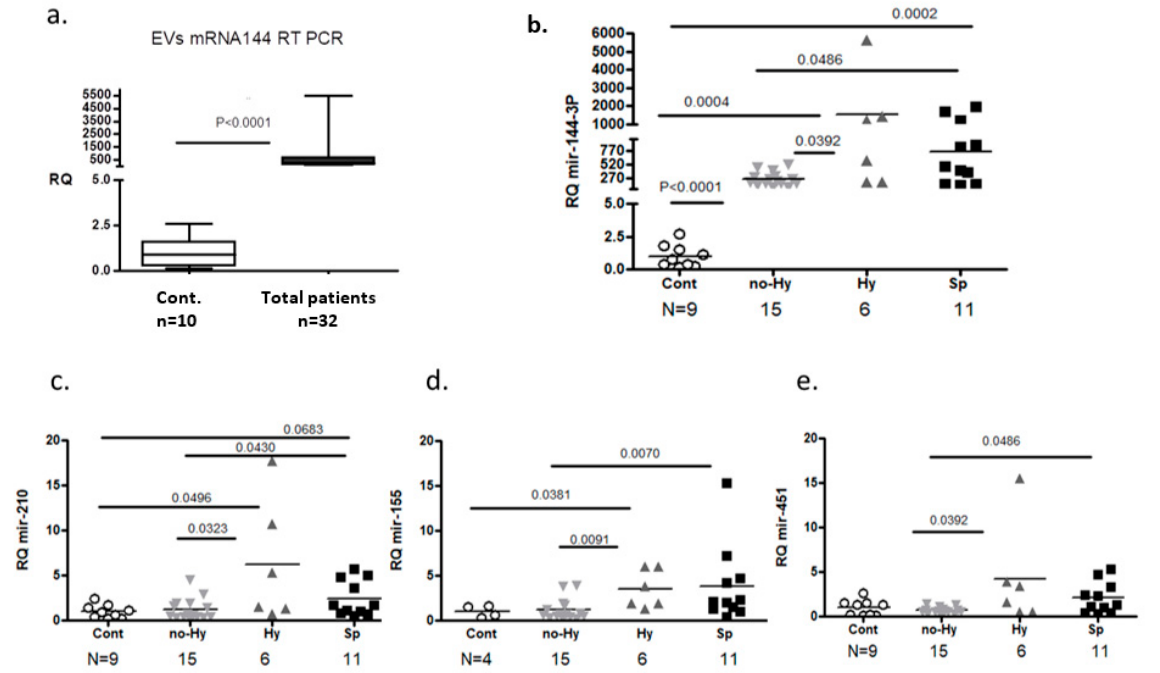
Figure 3. Relative expression levels of extracellular vesicle (EV) miR-144-3p by RT-qPCR. ( a ) Controls (Cont) (N = 10) vs. the total β thalassemia (Total β T) group. ( b – e ) Controls vs. β T subgroups (hypersplenism (Hy), no hypersplenism (no-Hy), splenectomized (Sp)) miR-144-3p, miR-201, miR-155-5p, and miR-451a, respectively. The results were normalized to cel-miR-39 spike-in expression and to the control group.